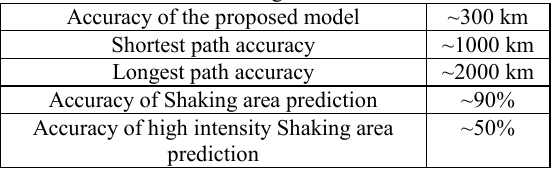
Table 1 The accuracy of the proposed